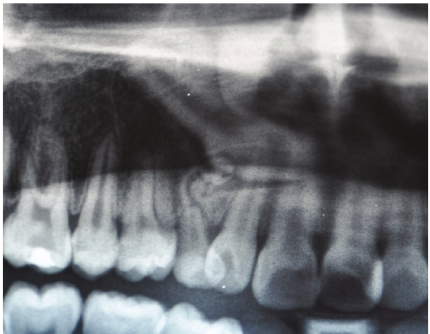
Figure 2: Panoramic X-ray